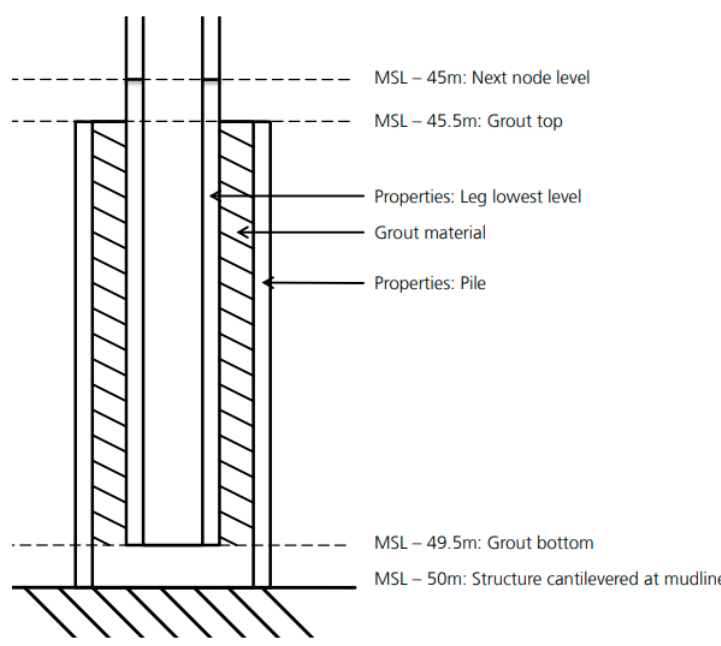
Figure 2. A grouted connection between pile and leg [29].